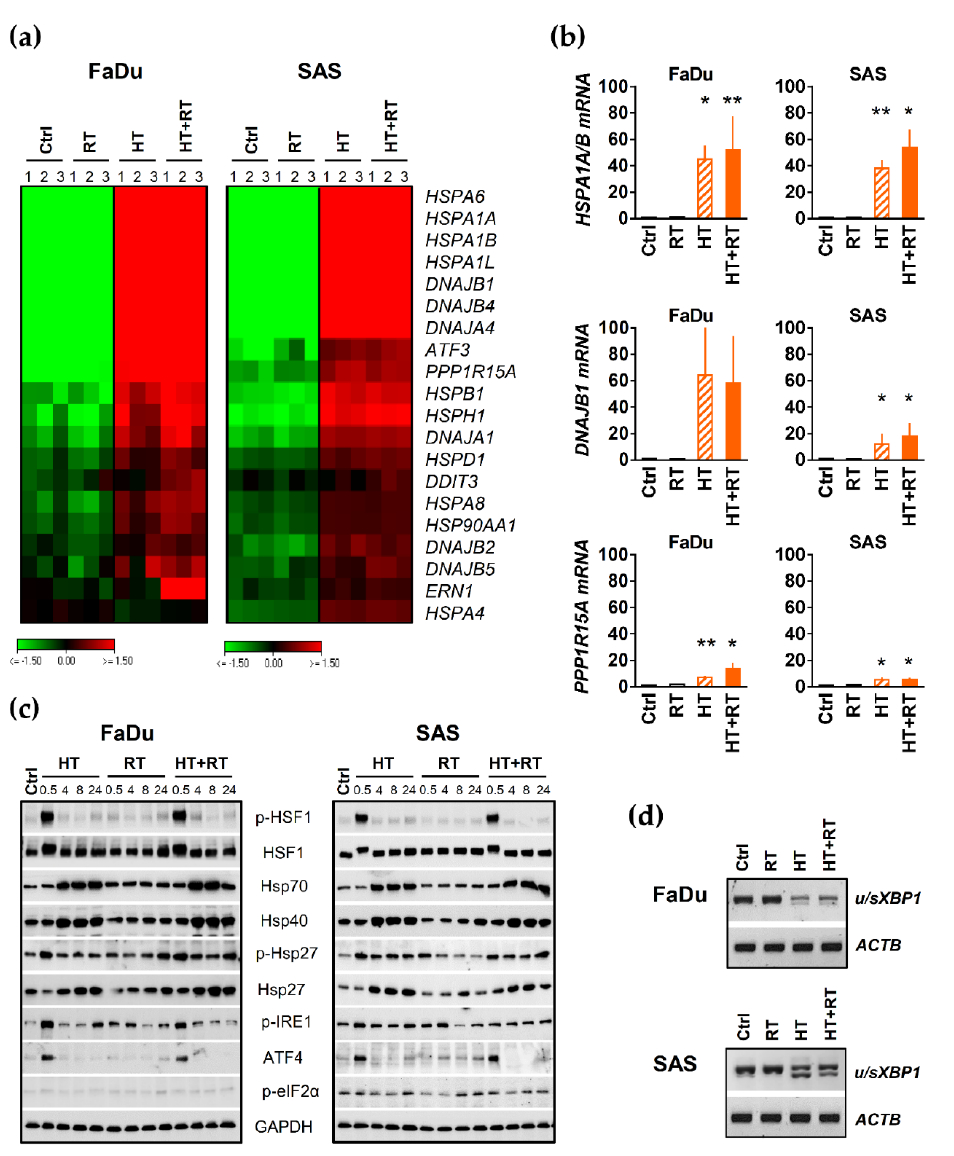
Figure 4. HT triggers heat shock response and proteotoxic stress in HNSCC spheroids: ( a ) Heat map of differentially expressed HSR and UPR genes in FaDu and SAS spheroids within 0.5 h of treatments profiled by RNA-Seq analysis in triplicate. Genes were selected by DESeq2 with at least 2-fold changes in expression under HT + RT treatment as highlighted in Figure 3, relative to appropriate control spheroids (adjusted p ≤ 0.05). The color-coded data represent log2 values reflecting down-regulation in green and up-regulation in red. ( b ) q-PCR analysis of three selected genes identified as upregulated by HT and HT + RT treatments in FaDu and SAS spheroids in our RNA-Seq analysis. Data were normalized to ACTB gene expression and are shown as means (±SD) of N = 3 independent experiments; * p ≤ 0.05; ** p ≤ 0.01. ( c ) Western blot data sets showing the expression/activation of HSR and UPR proteins of interest in FaDu and SAS spheroids 0.5–24 h after exposure to HT and/or irradiation; GAPDH was used as loading control. ( d ) Representative PCR analysis documenting the splicing of XBP1 mRNA in FaDu and SAS spheroids 0.5 h after HT, RT and HT + RT treatments; the ACTB gene expression served as reference. Spheroid treatment conditions: Ctrl—control; RT—single dose irradiation (7 Gy for FaDu and 10 Gy for SAS); HT—hyperthermia (42.5 °C/60 min); HT + RT—hyperthermia and single dose irradiation according to mono-treatments.